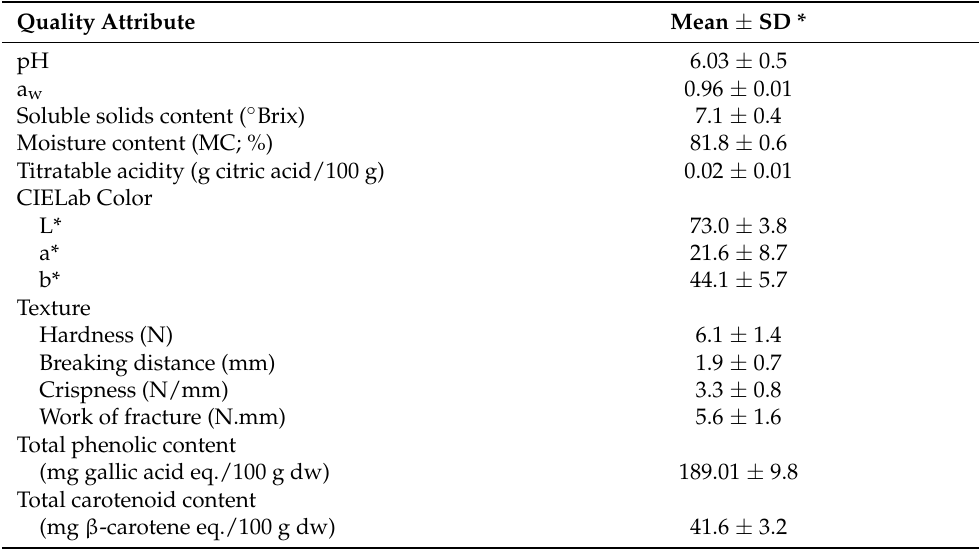
Table 1. Physical, chemical and phytochemical characterization of raw